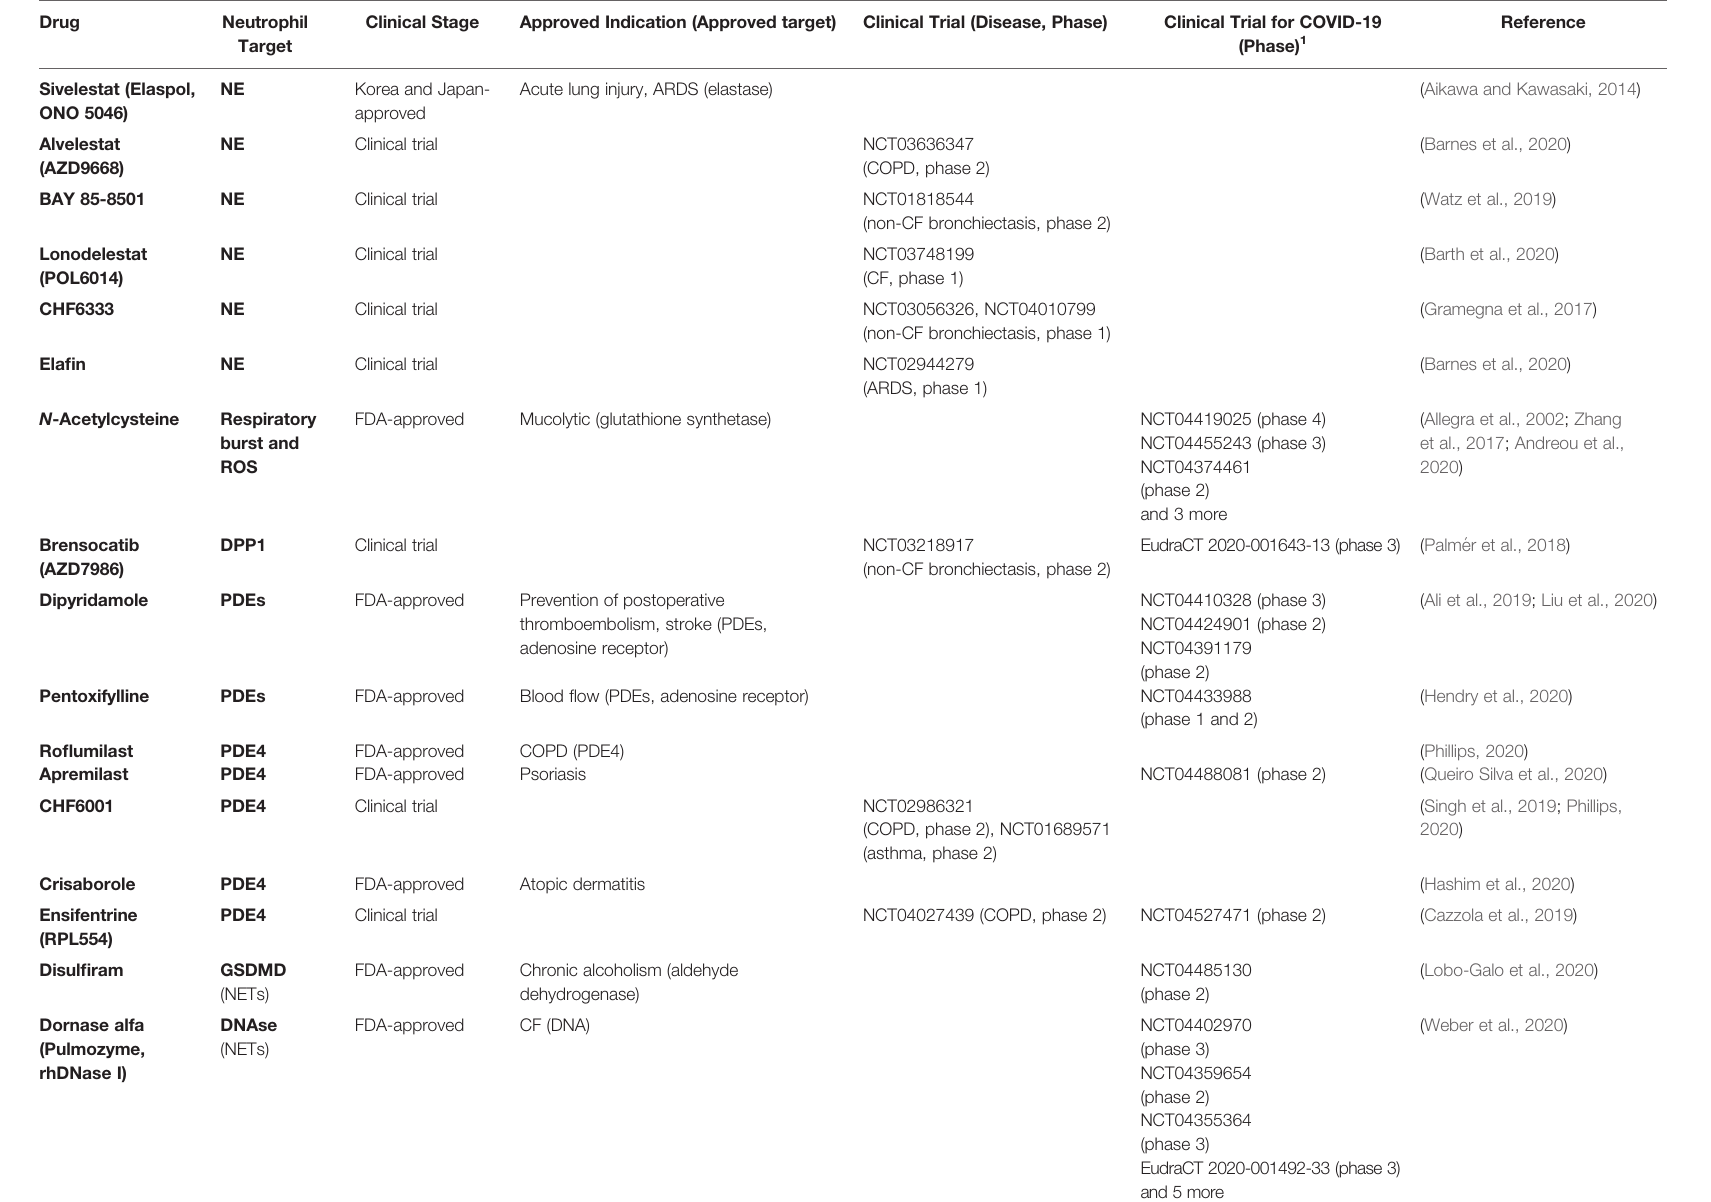
TABLE 1 | Drugs targeting